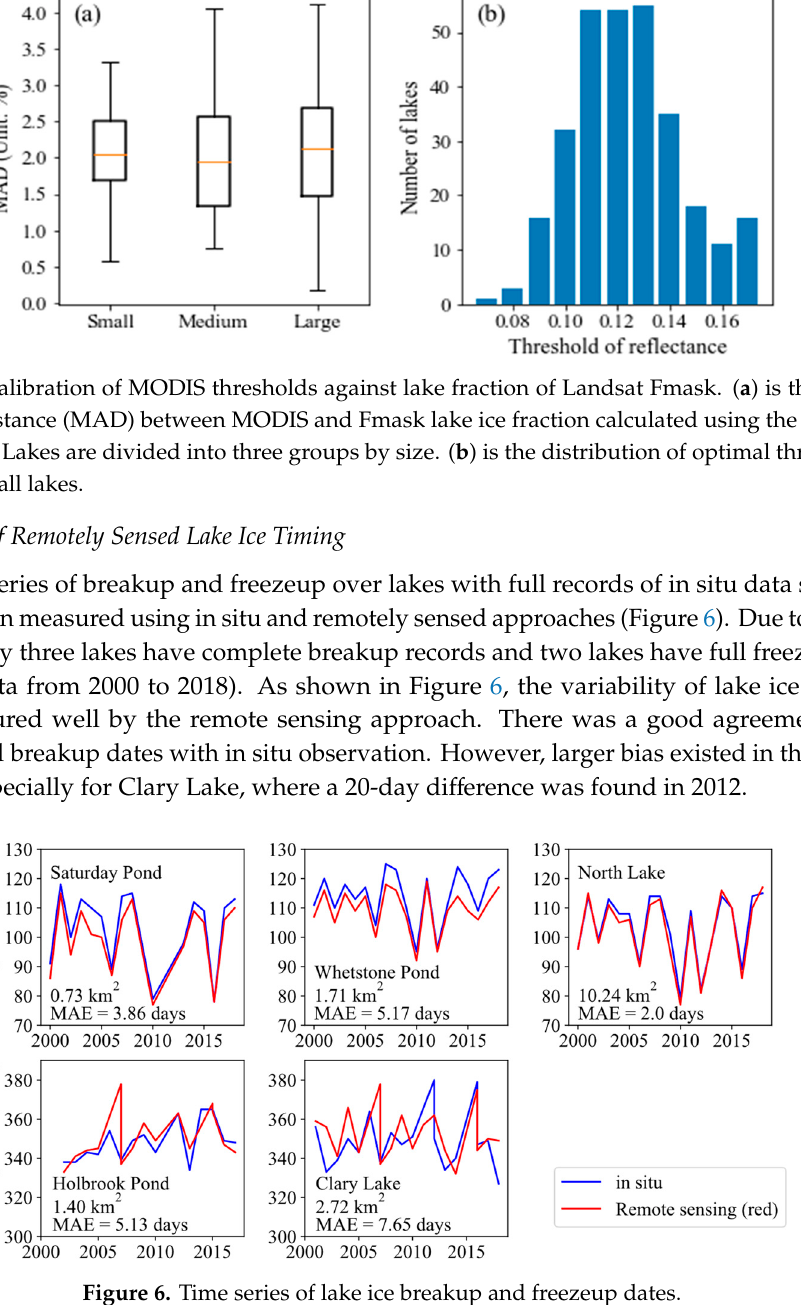
Figure 6. Time series of lake ice breakup and freezeup dates.